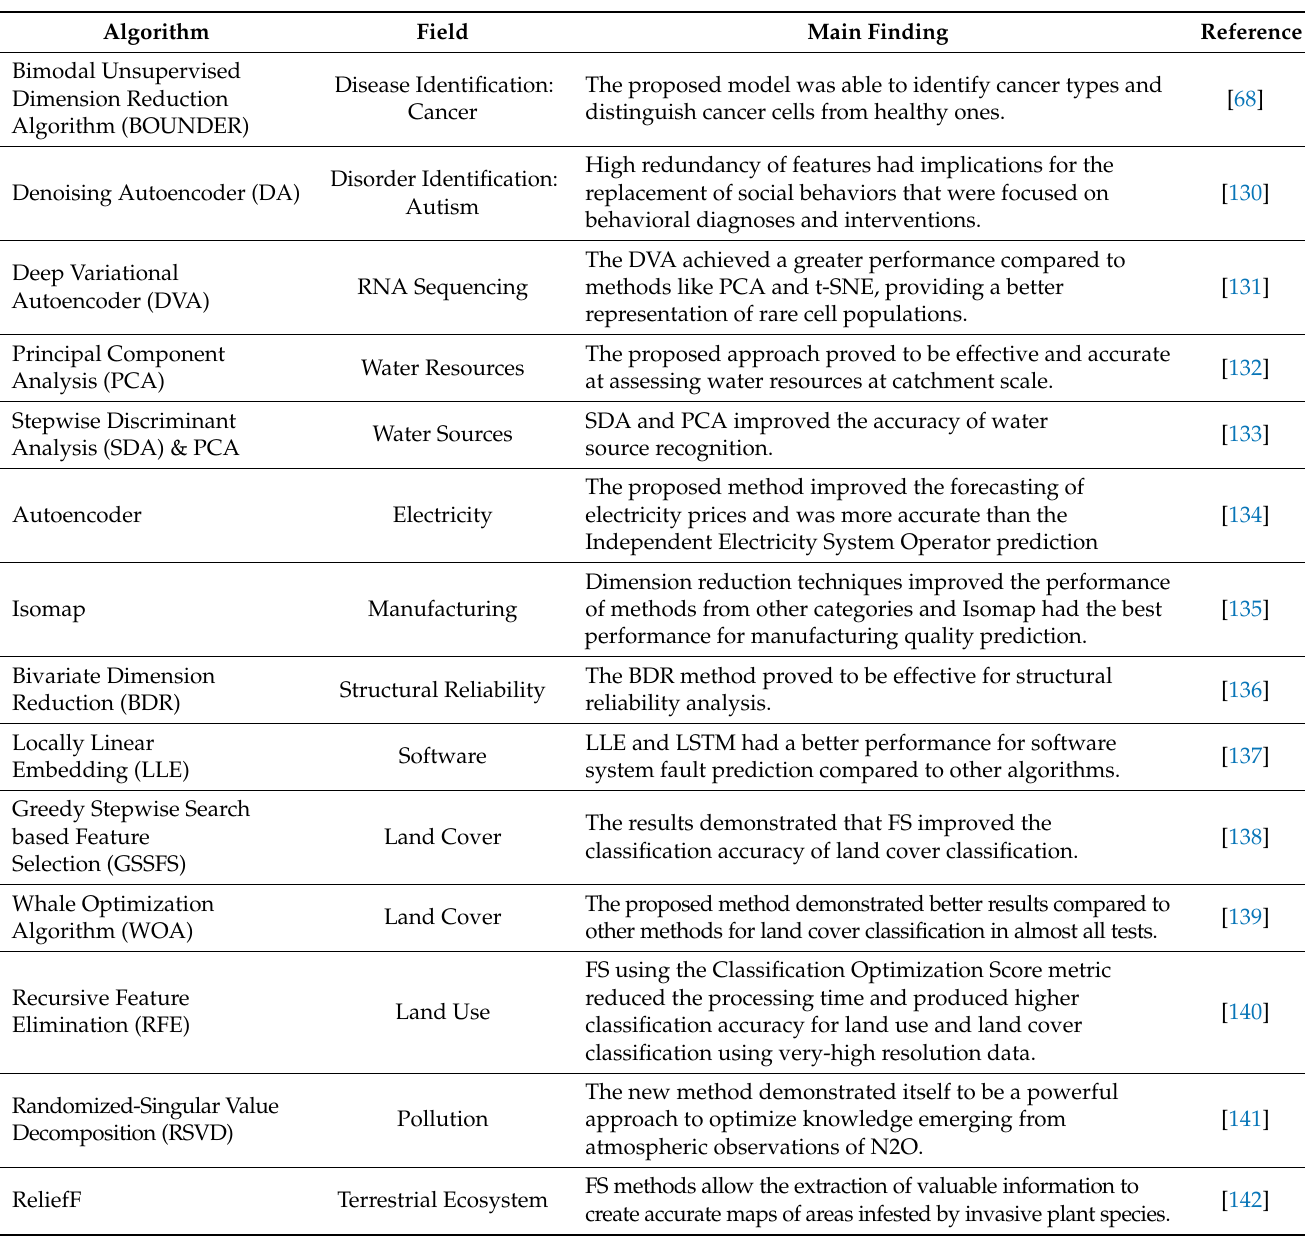
Table 4. Examples of application of dimensionality reduction approaches using EO